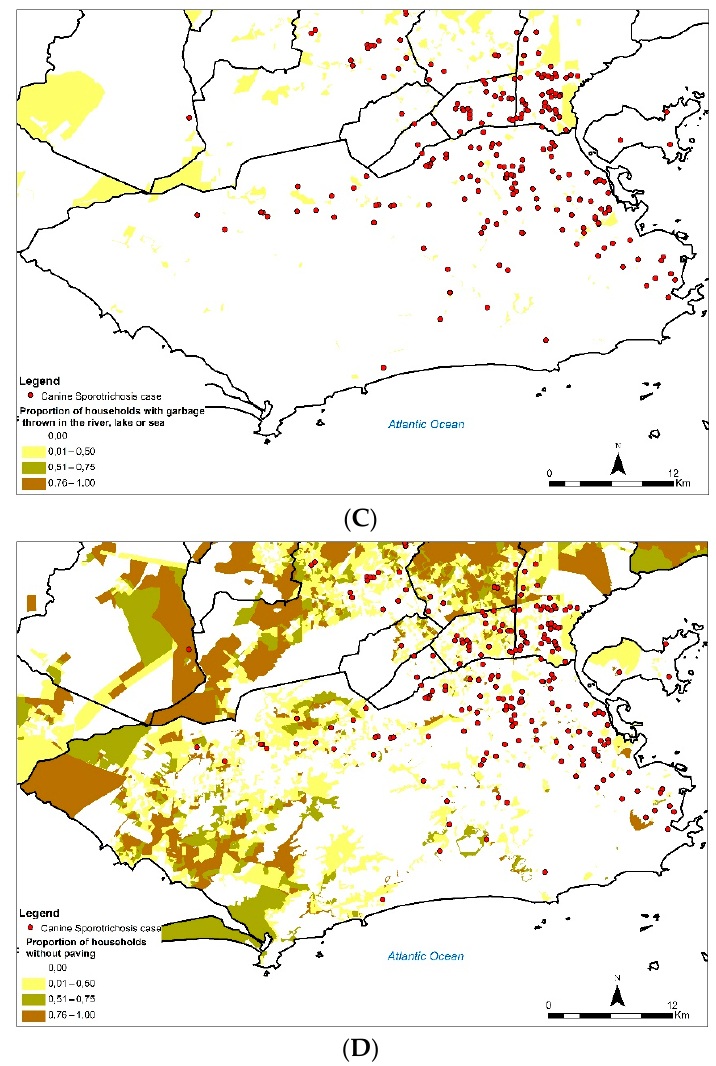
Figure 5. Number of cases of canine sporotrichosis in Rio de Janeiro, Brazil, between 1998 and 2018, superimposed on the proportion of the following indicators: ( A ) Proportion of houses as predominant dwelling type; ( B ) literate responsible persons; ( C ) households with garbage thrown in the river, lake, or sea; and ( D ) households without paving.